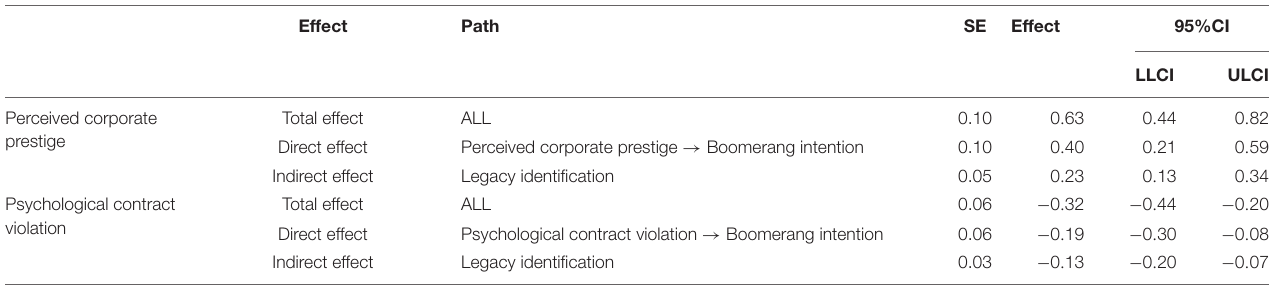
TABLE 4 | Results of mediation effect of legacy